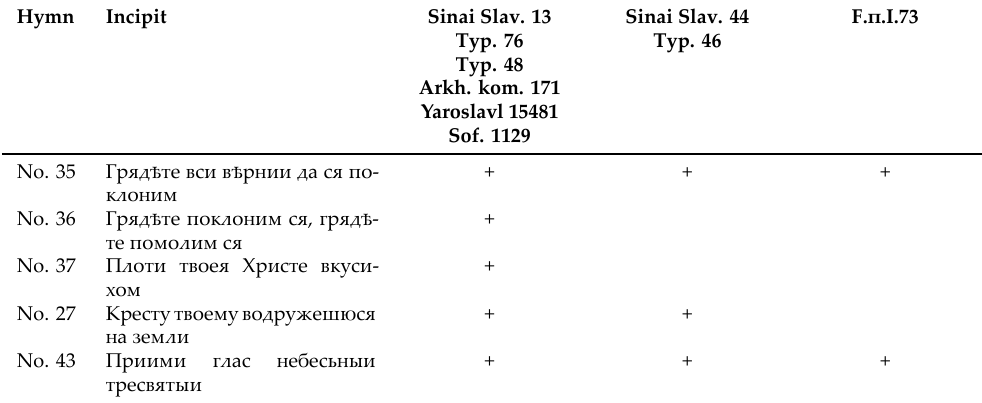
Table 1. The kata stichon hymns at Compline in the early Russian Horologion